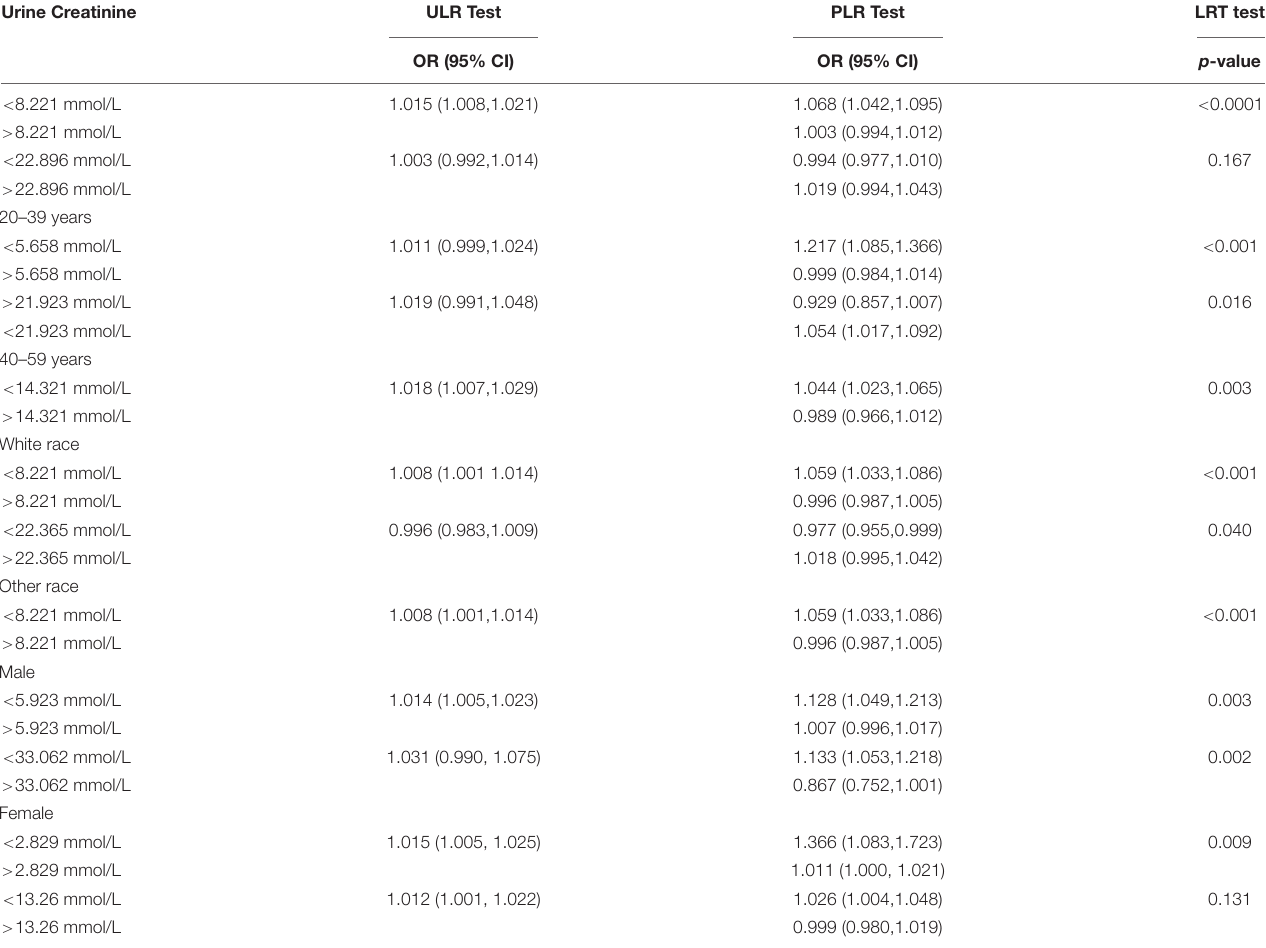
TABLE 4 | Two-piecewise linear regression and logarithmic likelihood ratio test explained the threshold effect analysis of UCR on the renal stone